Question: Reading the figure, is the described quantity rising or falling?
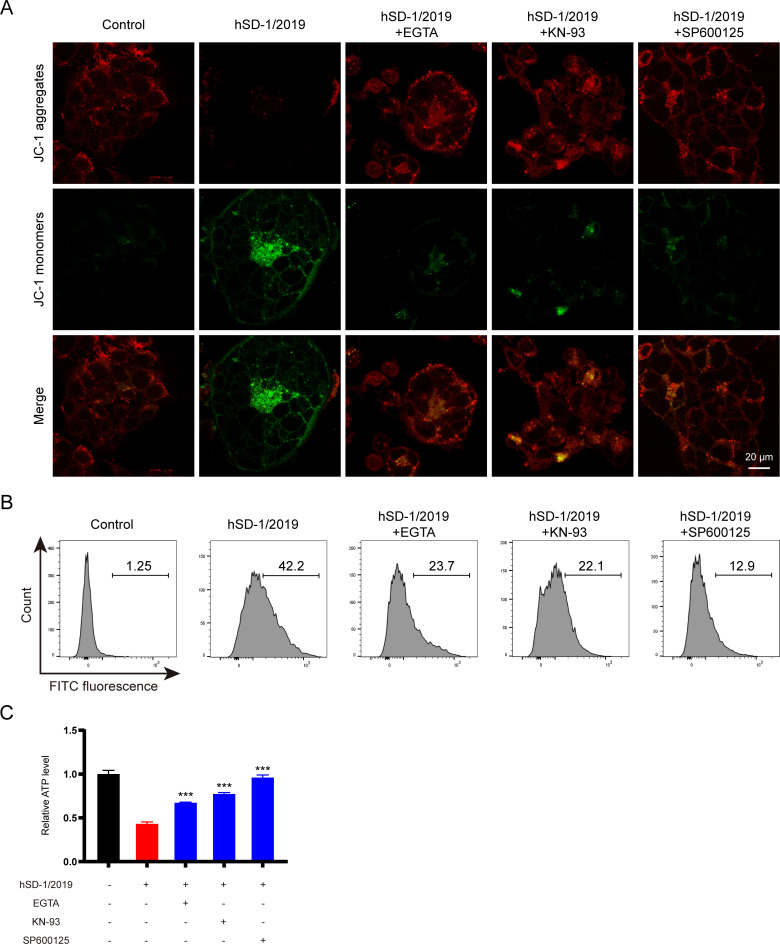
Answer: decreasing